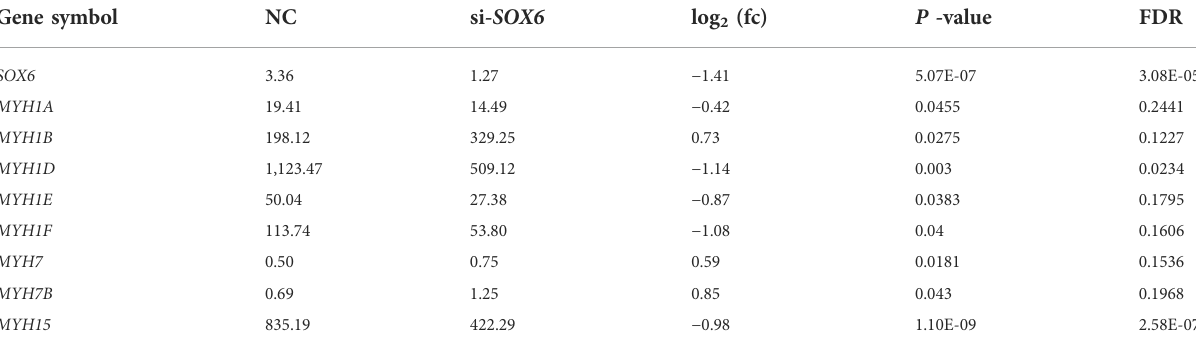
TABLE 3 Expression change of SOX6 and myosin genes in SOX6 knockdown CPMs compared with negative control. Gene